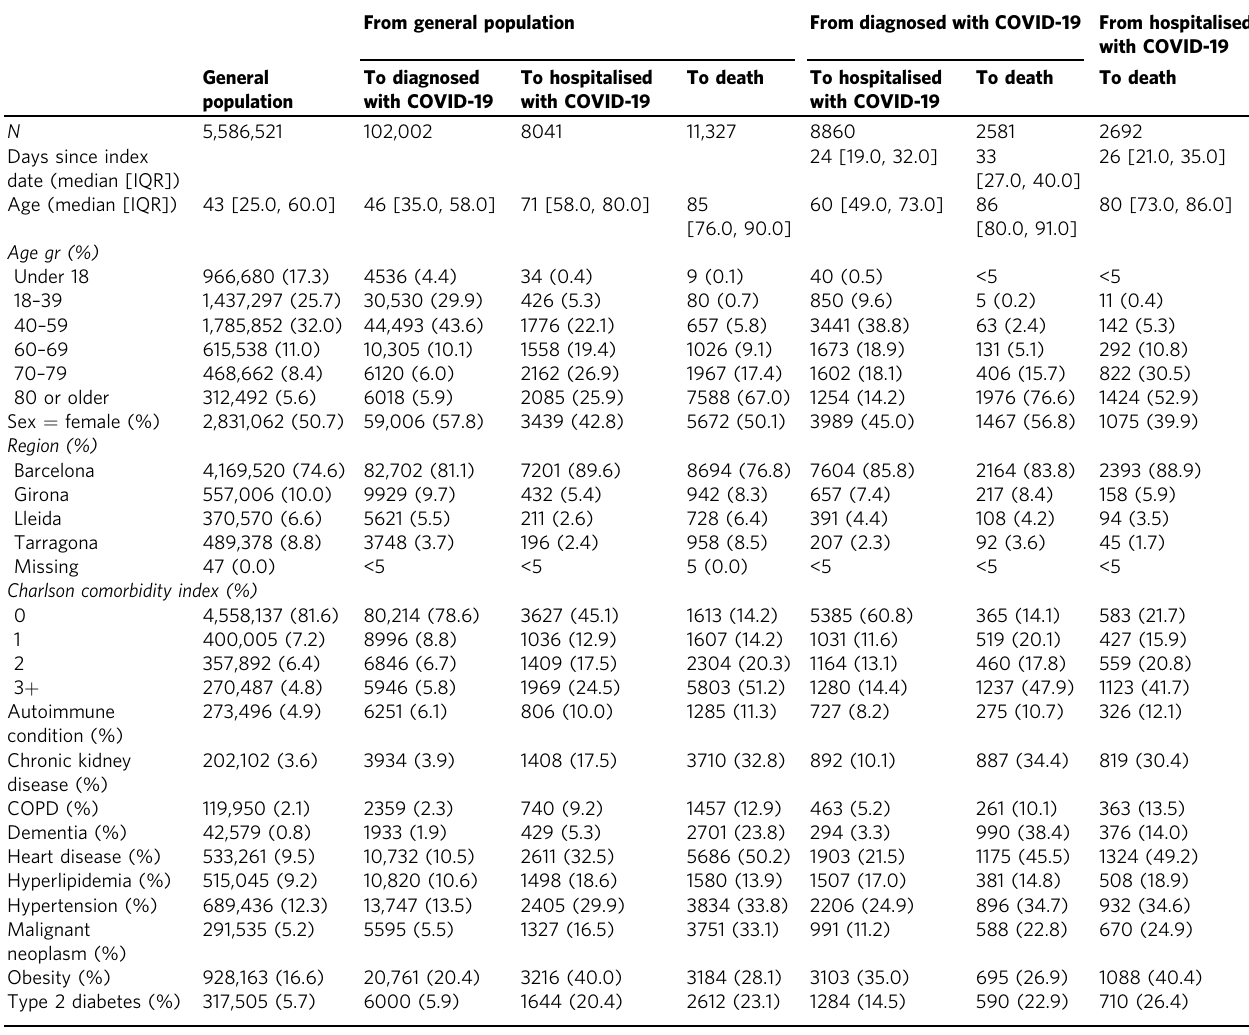
Table 1 Patient characteristics of the study population and by multistate transition. From general population From diagnosed with COVID-19 From hospitalised with COVID-19 General To diagnosed To hospitalised To death To hospitalised To death To population with COVID-19 with COVID-19 with COVID-19